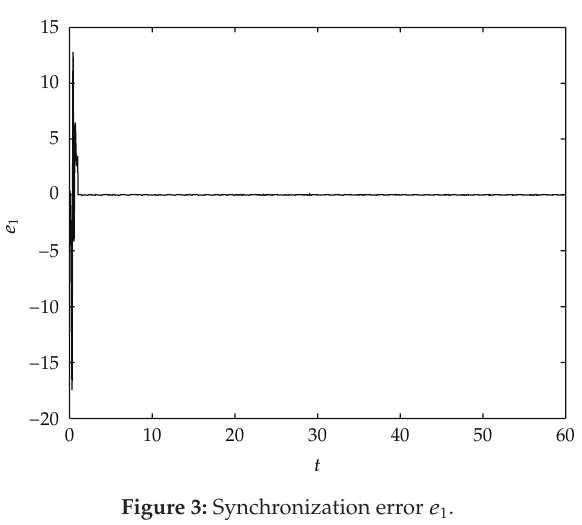
Figure 3: Synchronization error e 1 .